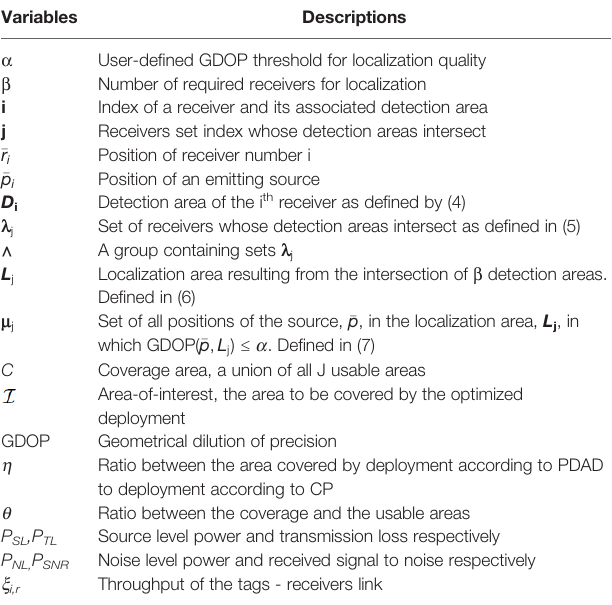
TABLE 2 | Main variables and notations - Coordinates ’ variables are marked by a macron sign, e.g., (cid:1) p